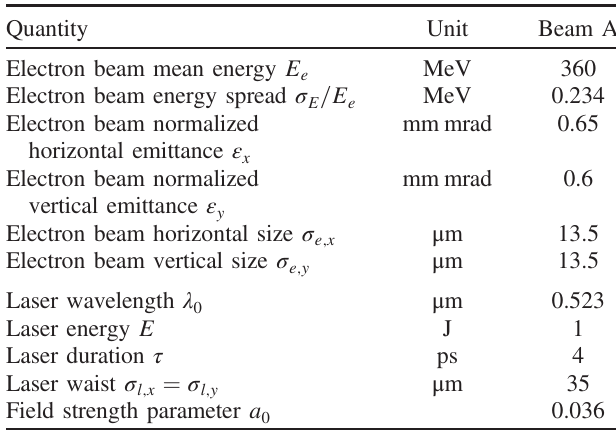
TABLE II. Main parameters of electron and laser beams for ELI-NP project [42].